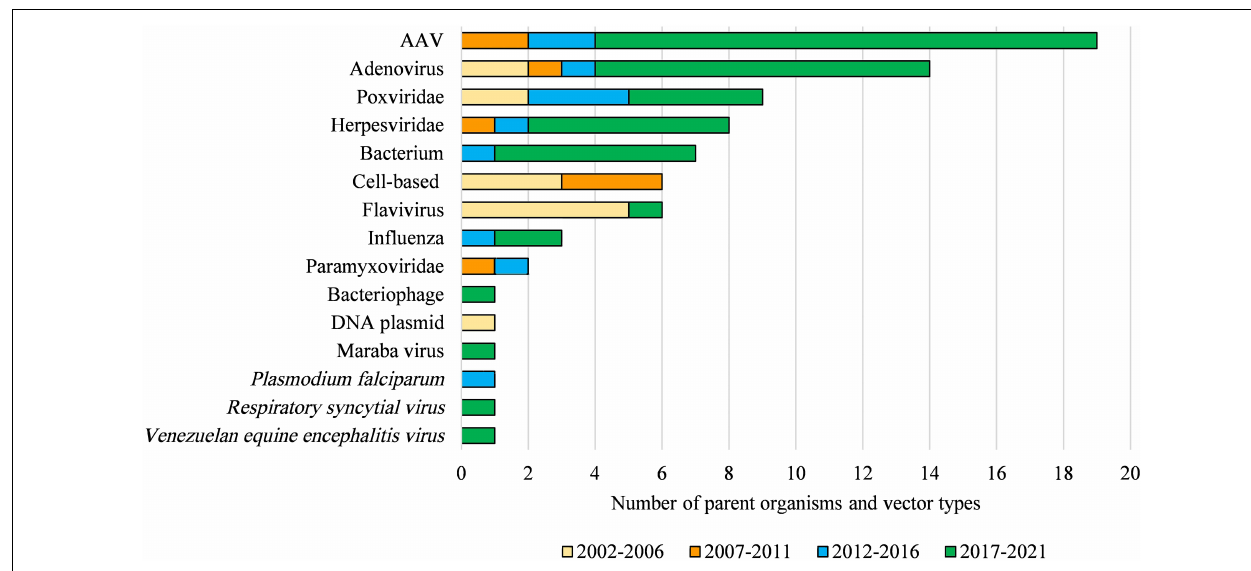
FIGURE 5 | Diversity of parent organisms and vector types used in licensed clinical trials from 2002 to 2021. AAV, Adeno-associated virus of various serotypes; Adenovirus , includes various human, chimpanzee, and ovine serotypes; Poxviridae, includes various strains of Vaccinia virus and Fowlpox virus ; Herpesviridae, includes Herpes simplex virus 1 and Human cytomegalovirus ; Bacterium, includes Bifidobacterium longum, Bordetella pertussis , Listeria monocytogenes , Mycobacterium bovis and Vibrio cholera; Flavivirus, includes Yellow Fever and Dengue viruses; Paramyxoviridae, includes Bovine parainfluenza virus and Sendai virus . DNA-based vaccines and cell-based therapies ceased to be regulated by the OGTR in 2007 and 2011, respectively. This Figure does not include parent organisms in commercial licenses. For further information and details for these data see Supplementary Table 1